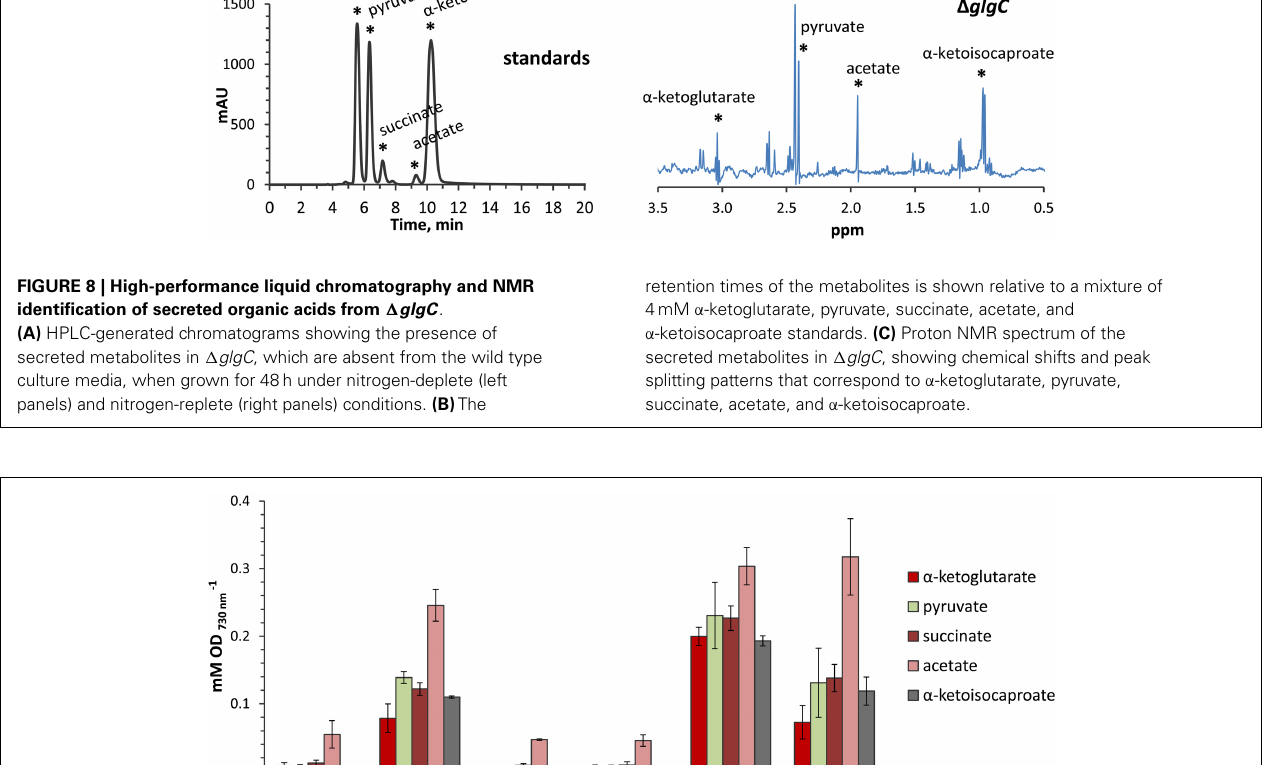
FIGURE 9 |Accumulation of excreted organic acids in the spend media of cells grown under nitrogen starvation for 48h . Concentrations of organic acids were measured by HPLC analysis and presented relative to cell optical density at 730nm. Error bars represent standard deviation from three biological